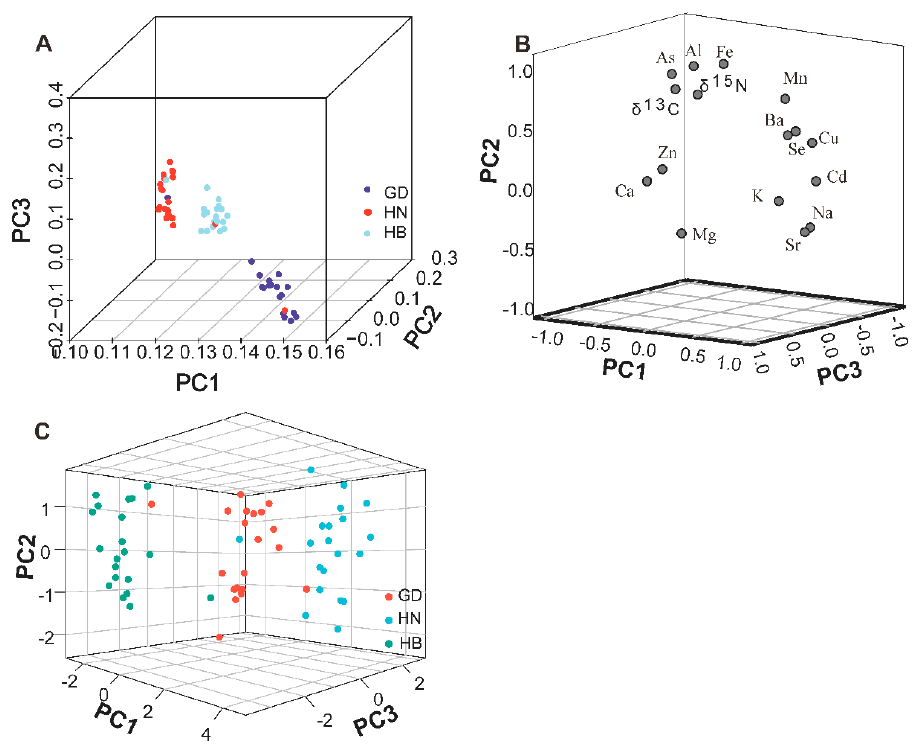
Figure 6. Principal component analysis of P. clarkii variables sampled from different regions. PCA score plot combines the element compositions with the stable isotope ratios in the variables ( A ). Distribution diagram of the main elements influencing the principal components ( B ). Three-dimensional scatter diagram of the samples based on the main contributing elements of the principal components ( C ).